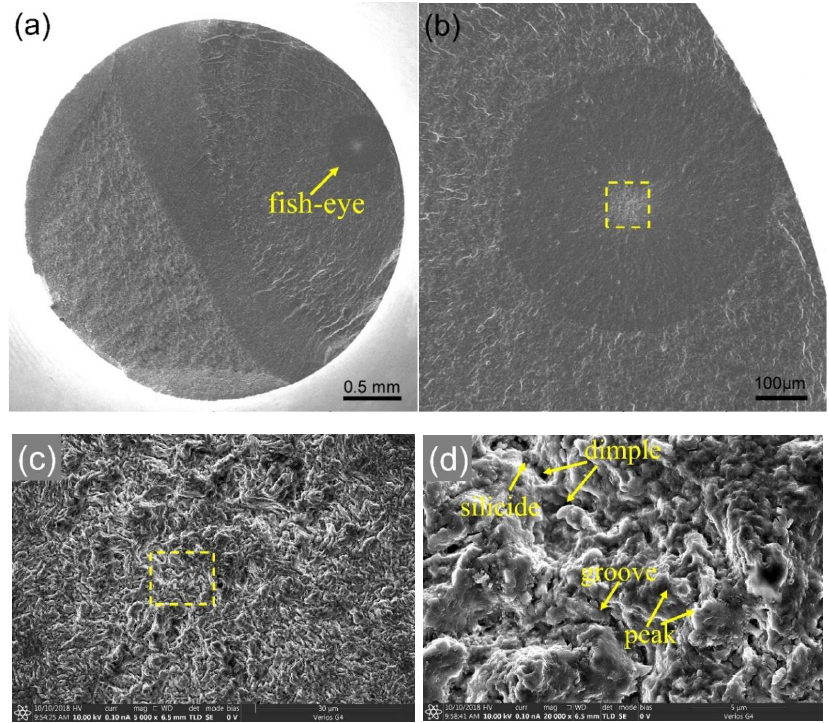
Figure 8. Fracture surface of an electropolished sample tested at σ a = 680 MPa, failed after N f = 1.81 × Figure8. Fracturesurfaceofanelectropolishedsampletestedat σ a = 680MPa, failedafter N f = 1.81 × 10 10 8 cycles in the VHCF regime: ( a ) overall view showing the internal crack initiation, ( b ) magnified image of the fish-eye pattern in ( a ), ( c ) central area of the fish-eye pattern in ( b ) showing ductile damage appearance, ( d ) detailed morphology of the rectangular area in ( c ) showing dimples, silicides, grooves and peaks.